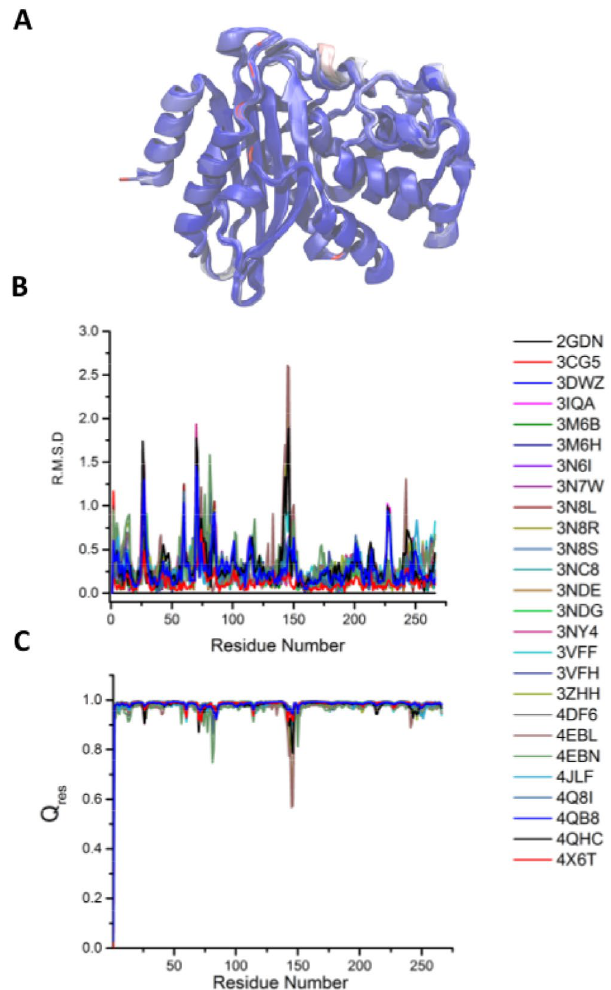
Figure 1. Comparison of the crystal structures of Mycobacterial ß-lactamase. ( A ) 26 crystal structures of BlaC aligned on 2GDN and colored according to their Root Mean Square Deviation (RMSD) from blue for the regions with lowest RMSD to red for the regions with highest RMSD. ( B ) and ( C ) are plots of RMSD and Q res ,